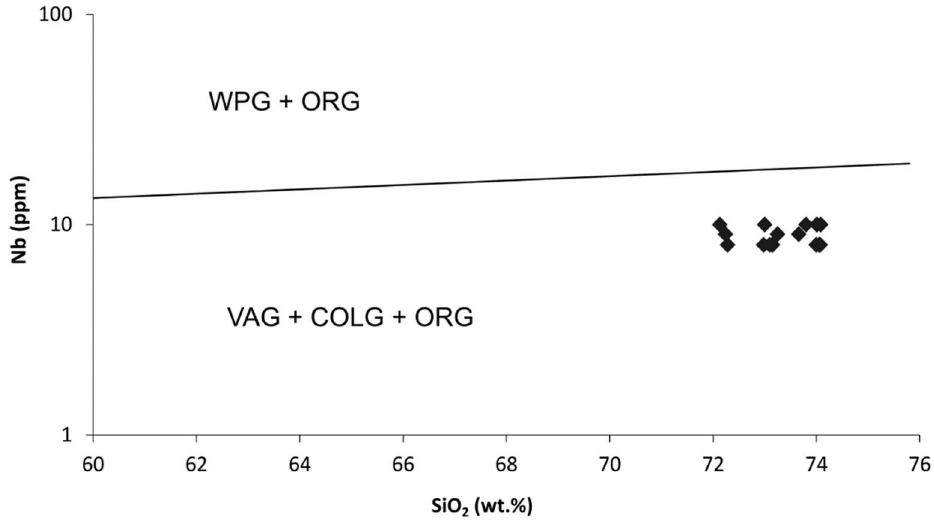
Figure 13. Nb (ppm) vs. SiO 2 (wt.%) diagram. The line divides the diagram into two fields which represent possible environments of granitoid formation. WPG: within plate granites; ORG: oceanic ridge granites; VAG: volcanic arc granites; COLG: collisional granites (modified after [57]).